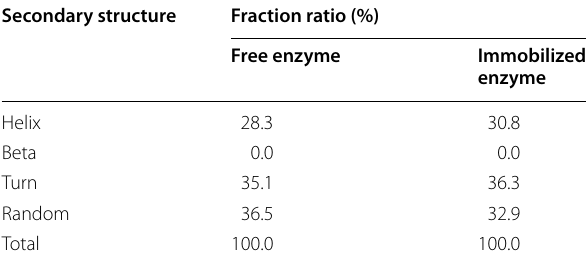
Table 2 Secondary structure fraction ratio of free and immobilized enzyme